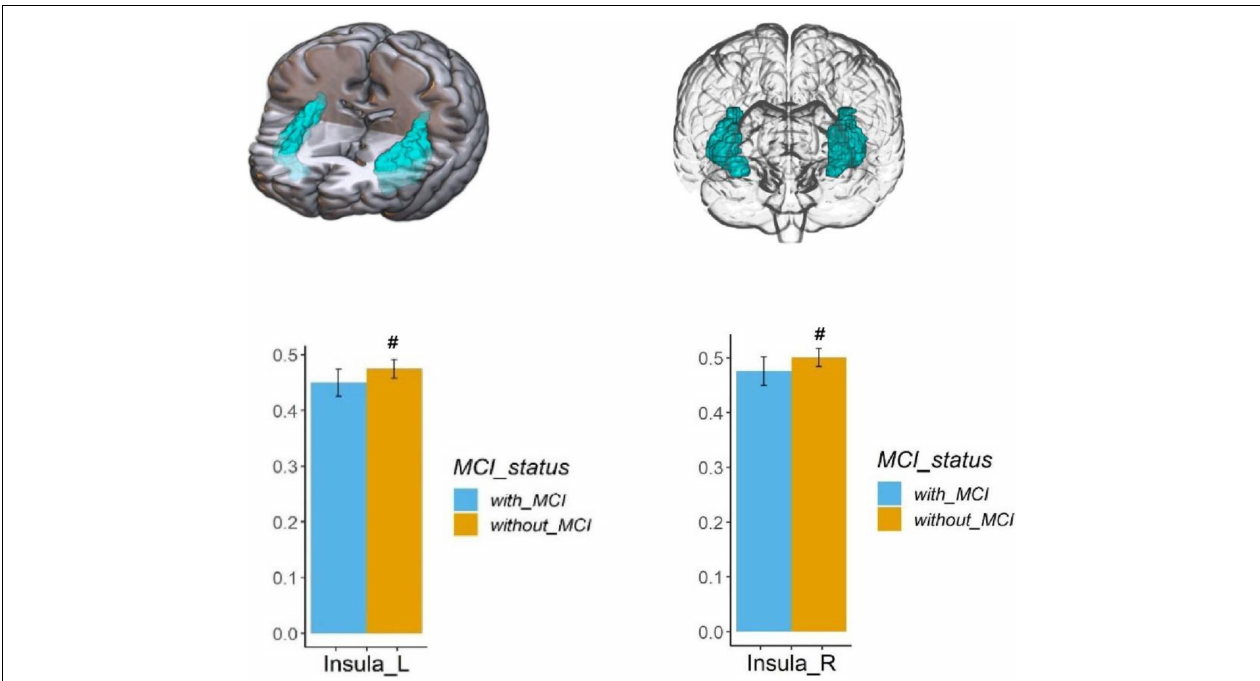
FIGURE 1 | Regional GM density comparison between the HA (with MCI) and LA (without MCI) groups. Above: The blue area shows the reduced GM density of the bilateral insula ( P < 0.05, Bonferroni corrected). Below: The bars represent statistical comparison of the bilateral insular GM density between the HA group and LA group. L – left hemisphere, R – right